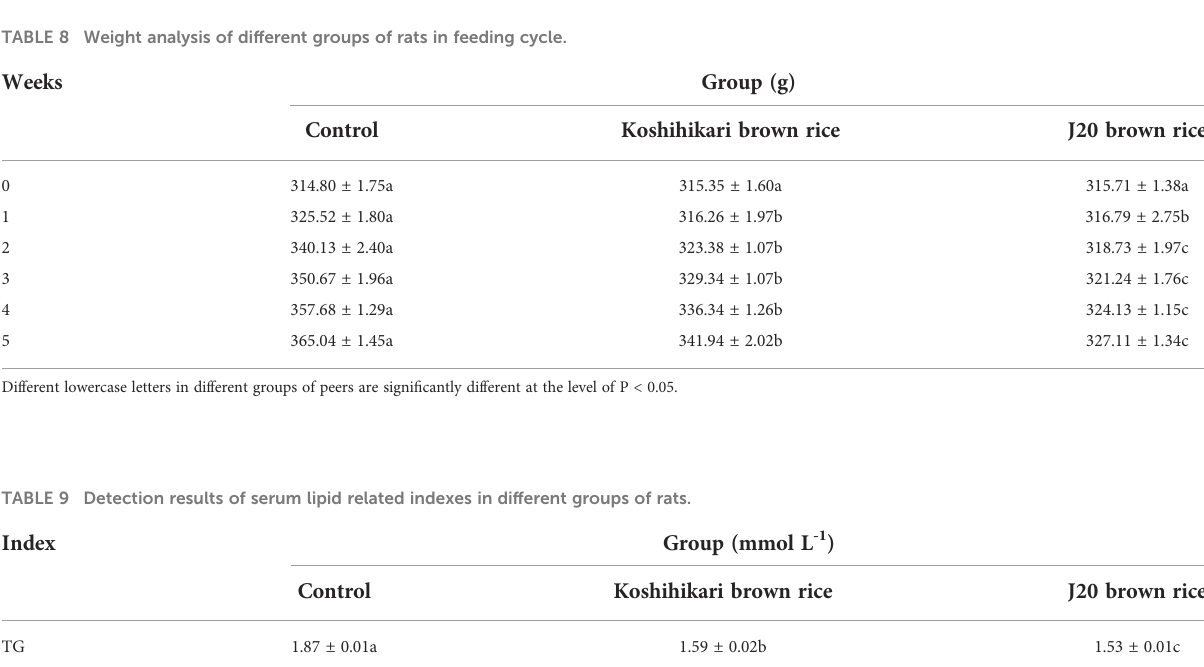
TABLE 8 Weight analysis of different groups of rats in feeding cycle.